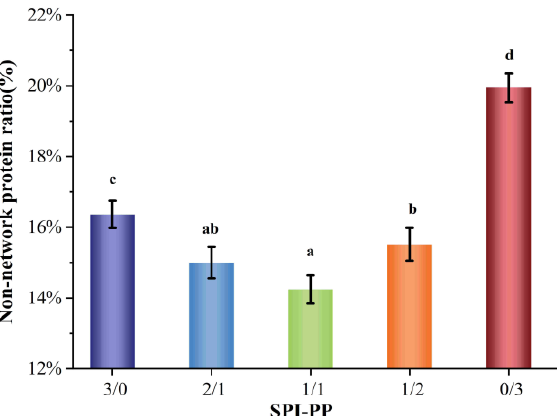
Figure 1. Non-network protein content of composite gels at different SPI and PP ratios. Different lowercase letters indicate significant differences between samples in the same group ( p < 0.05).